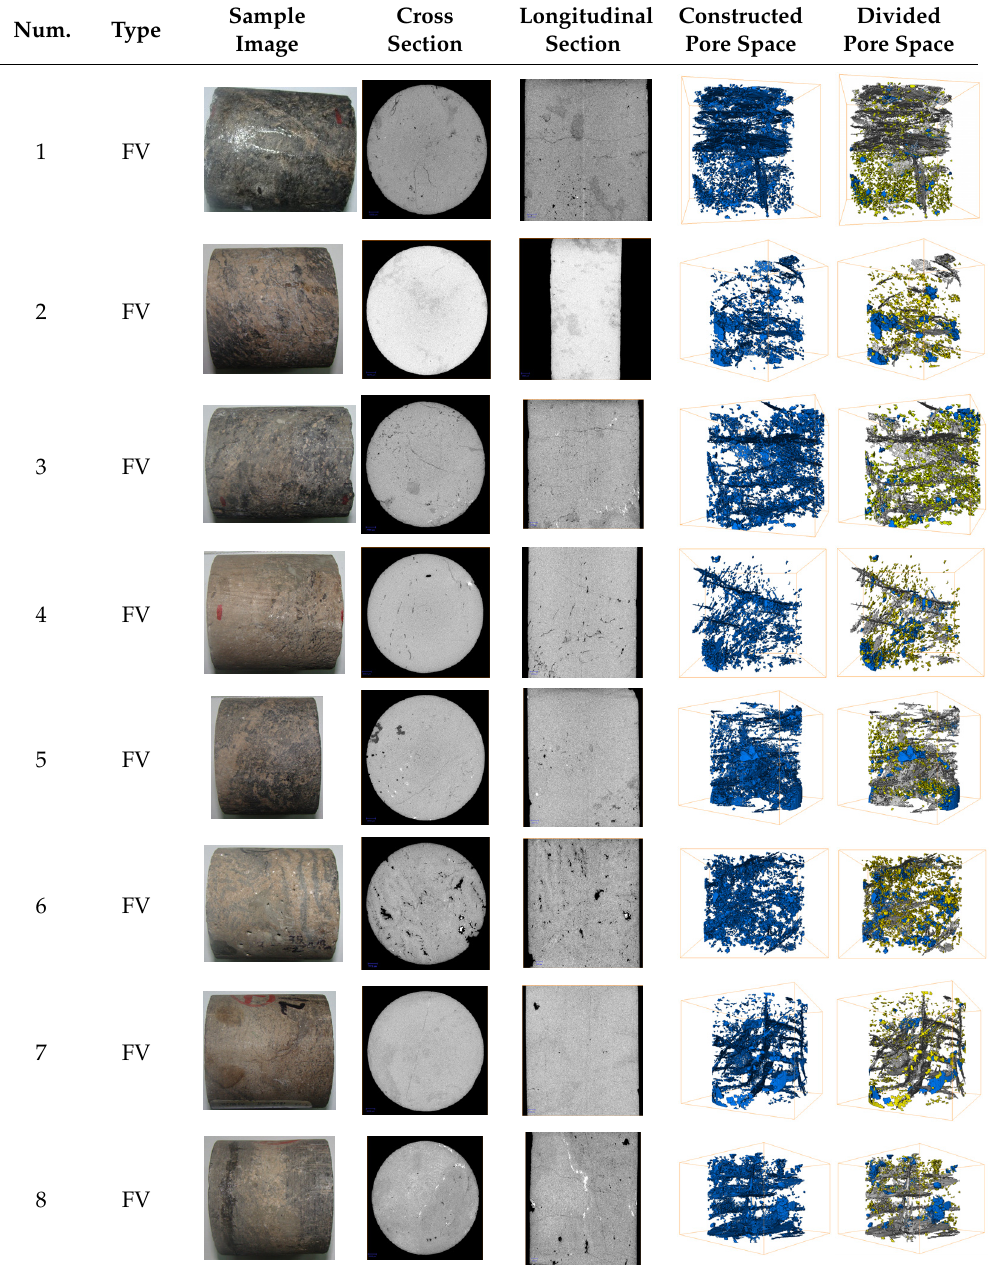
Table A1. Photos, cross and longitudinal sections of the CT scanning image, constructed pore spaces, and divided pore spaces of the remaining carbonate samples. This figure together with Figure 8 provides the constructed and divided pores spaces of all the collected tight carbonate samples. ‘FV’, ‘F’, and ‘V’ represent fractured-vuggy carbonate, fractured carbonate, and vuggy carbonate, respectively. In the last column, the fractures, vugs, and pores are colored in gray, blue, and yellow, respectively. The subgraphs are too small that a scale would be hard to see if it is directly marked on the subgraph. Thus, instead of a scale, we provide the physical size including the radius and the length of all the samples in Table 1.